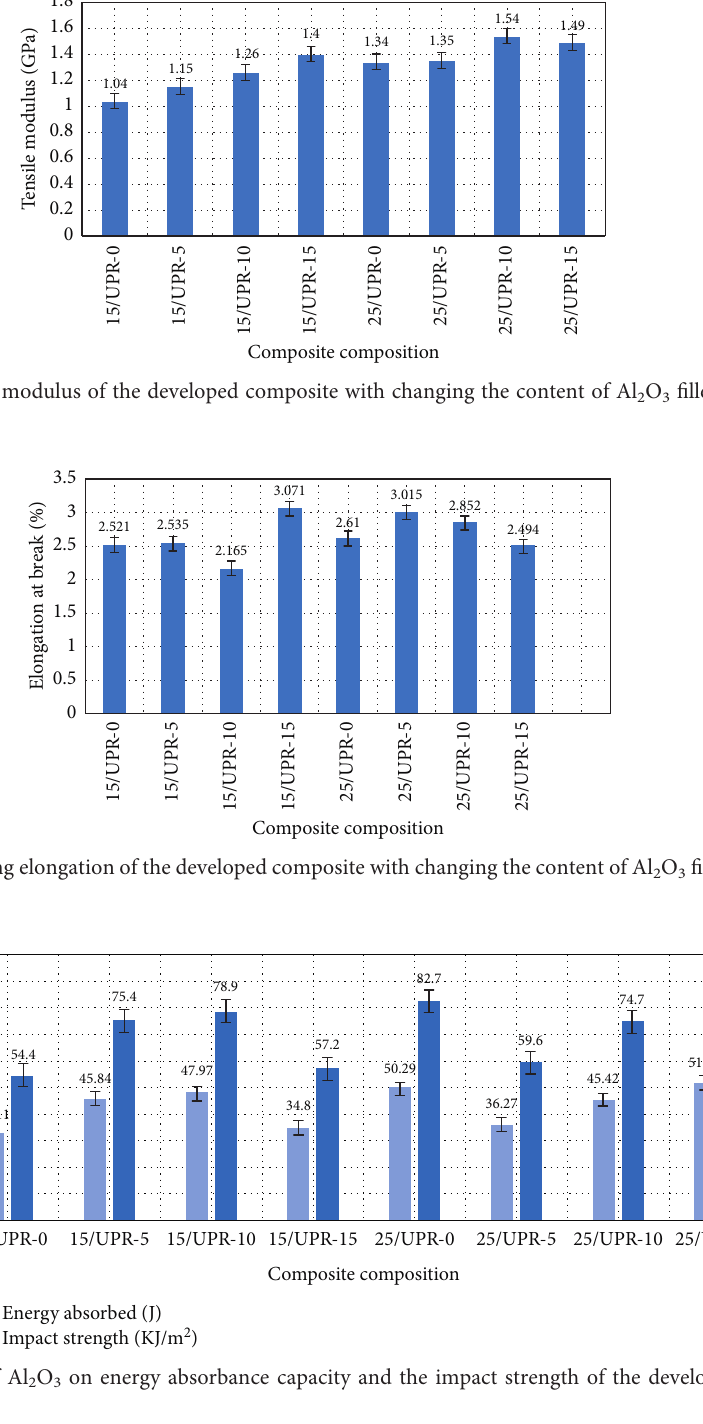
Figure 5: Influence of Al 2 O 3 on energy absorbance capacity and the impact strength of the developed composite.